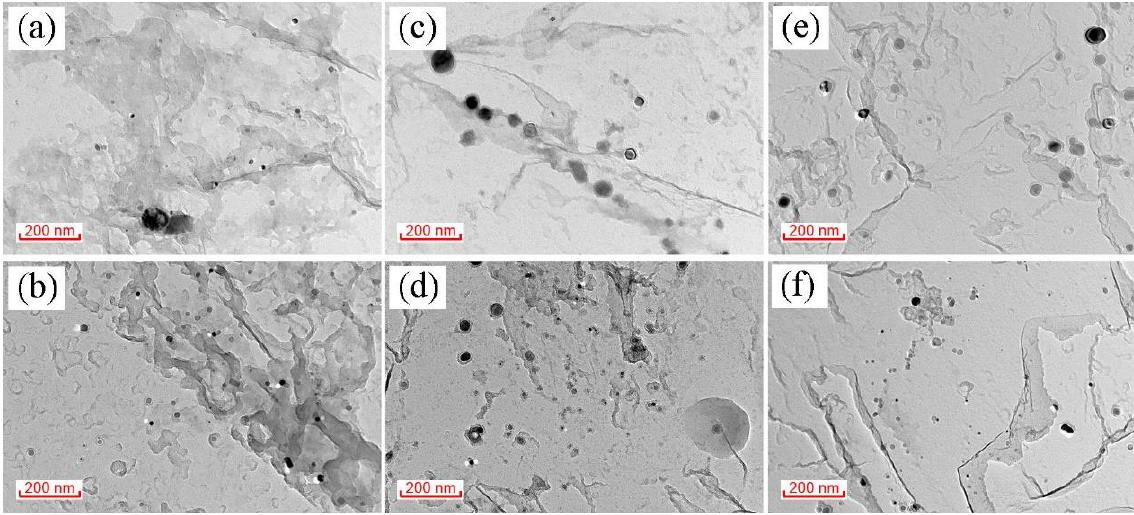
Figure 12. TEM micrograph of VC in 0.16V-2ST_200 specimen with SEAD pattern.